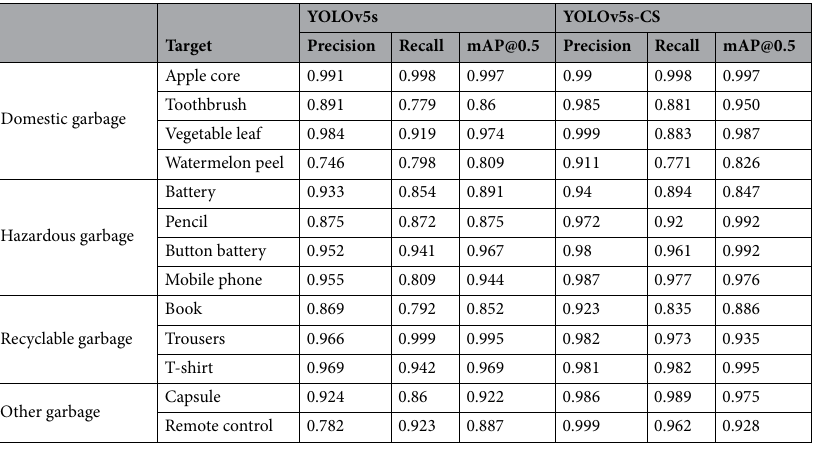
Table 5. Classification accuracy of the proposed YOLOv5s-CS model and YOLOv5s model for training the garbage dataset.